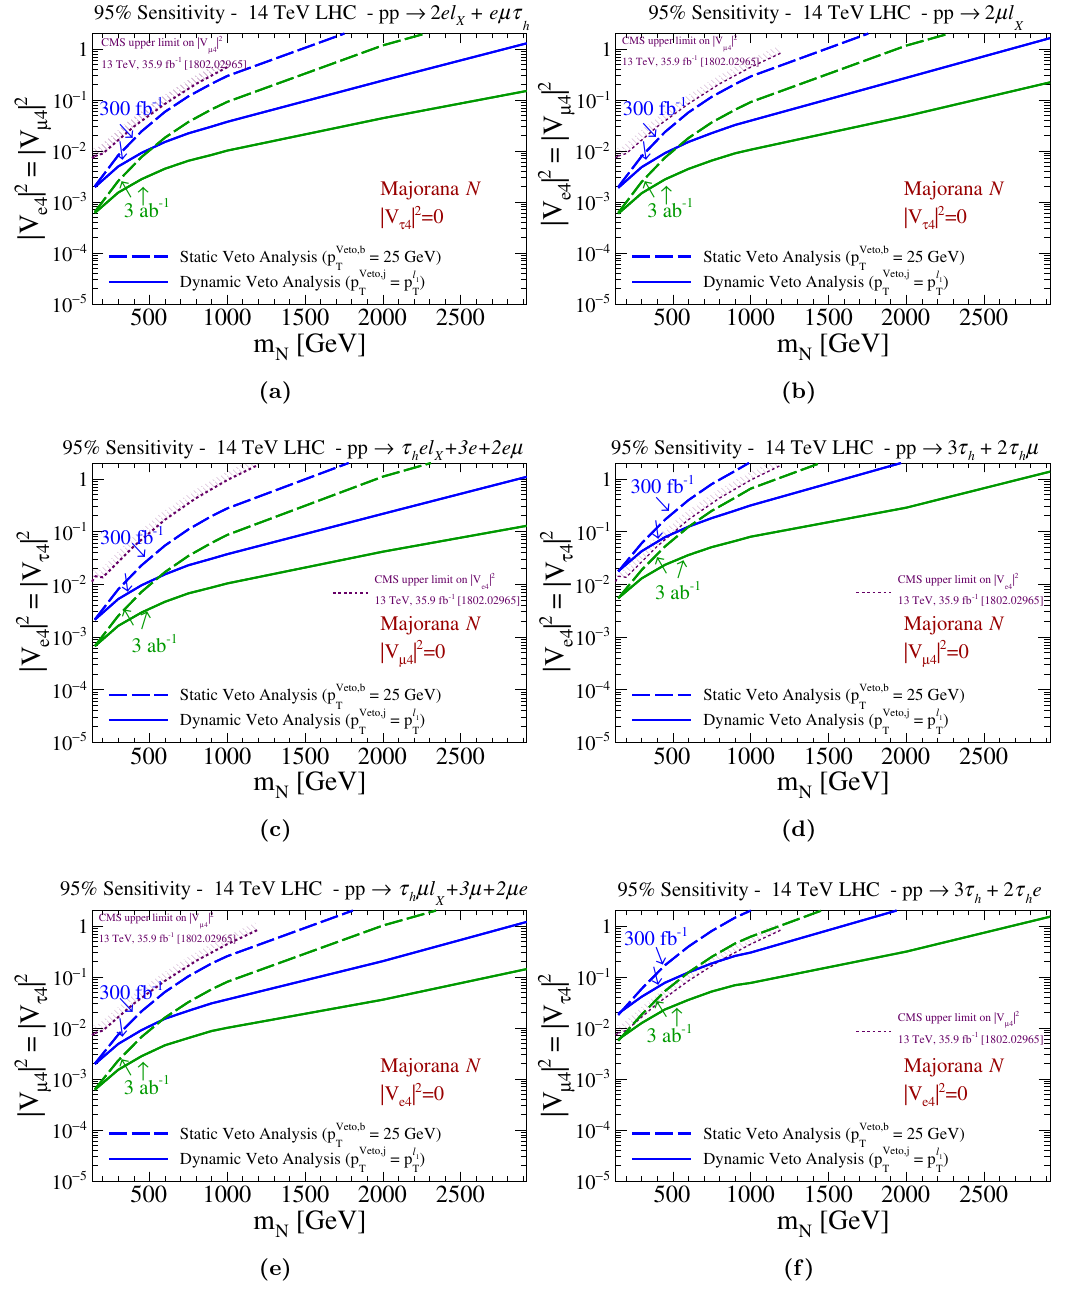
Figure 23. Same as (cid:12)gure 21 but for a single Majorana N in a phenomenological Type I